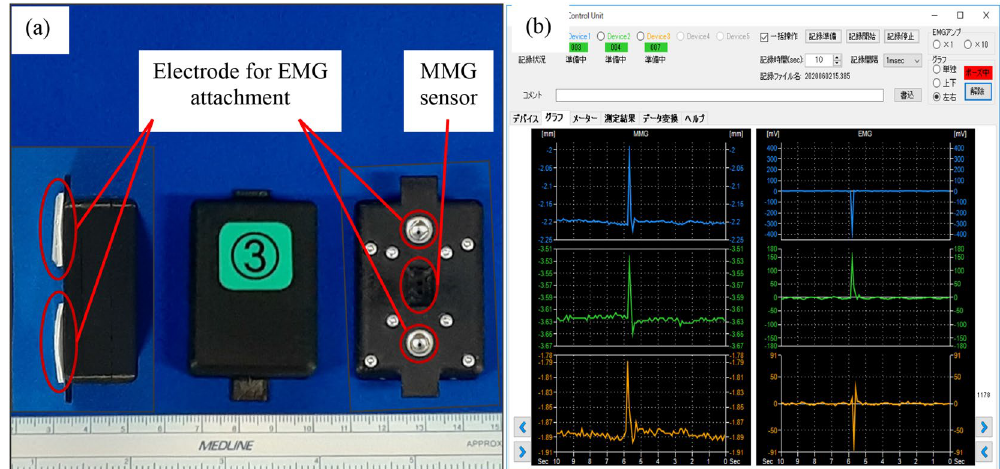
Figure 4. ( a ) Sensor size was 47 × 34 × 24 mm. A photo reflector-based MMG sensor was located in the center of the device. Disposable electrodes were attached to the bottom of the transducer. ( b ) Measurement and control software for operating the MMG/EMG sensor. The waveforms of MMG (left) and EMG (right) are shown on the screen. Up to five sensors could be controlled simultaneously. EMG: electromyography, MMG: